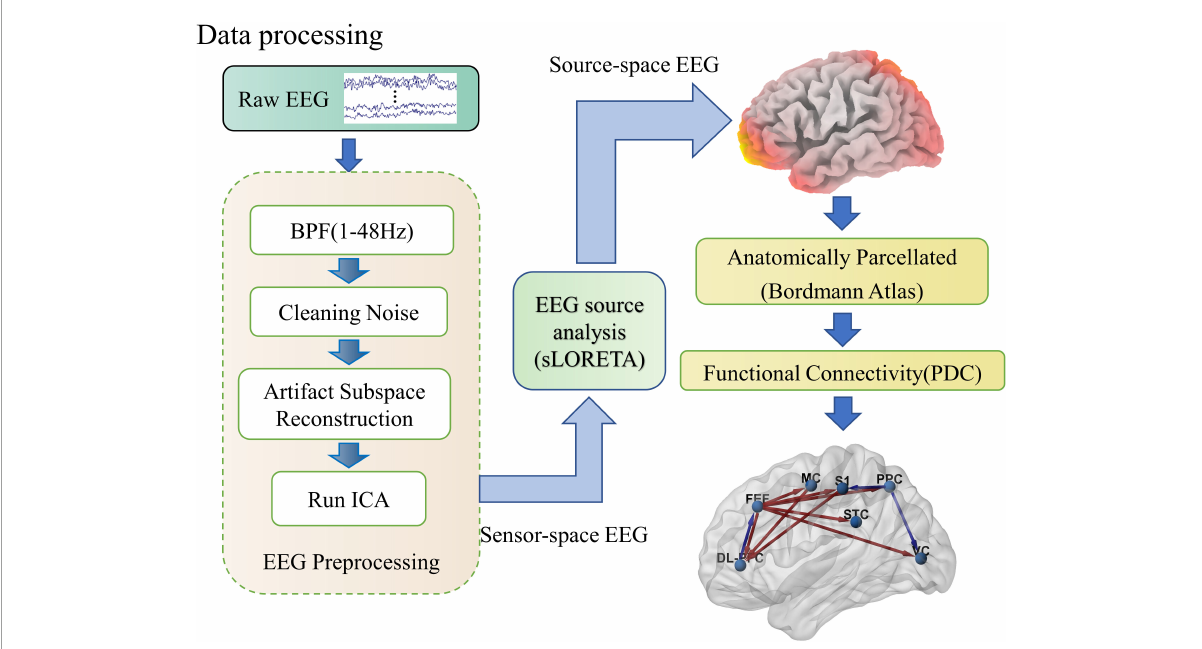
FIGURE2 Schematic diagram of the EEG processing flow. As shown in the figure, EEG processing includes three parts: preprocessing, soliton source analysis, and network connection calculation. In the preprocessing, raw EEG is cleaned up by band-pass filtering, removal of linear interference, artifact spatial reconstruction, and independent component analysis steps. Then the sensor space EEG is transformed into source activity and clustered into regions of interest by the sLORETA software package. Finally, the effective connections between cortical regions of interest are calculated quantitatively using